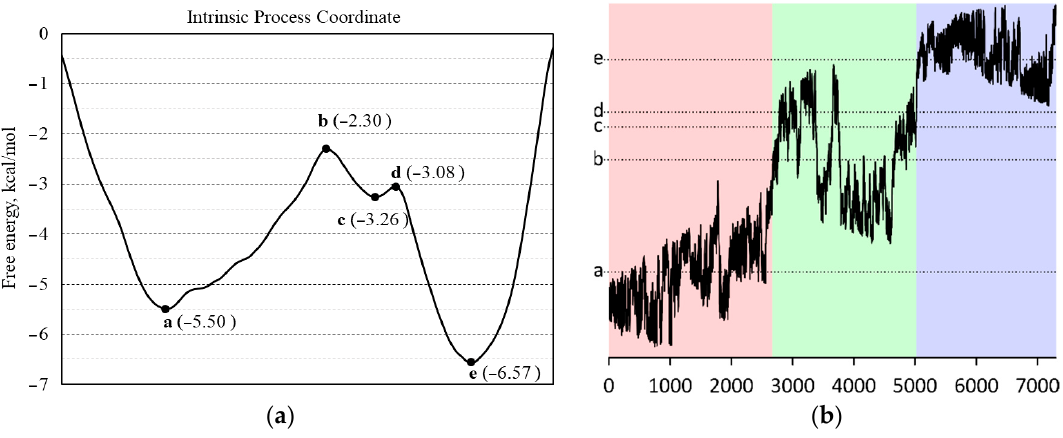
Figure 9. ( a ) The dependence of free energy on intrinsic coordinate during the phase transition in crystal of D4. The high-temperature phase is on the left, and the low-temperature phase is on the right side of plot. ( b ) The path of intrinsic coordinate (vertical) during metadynamics.